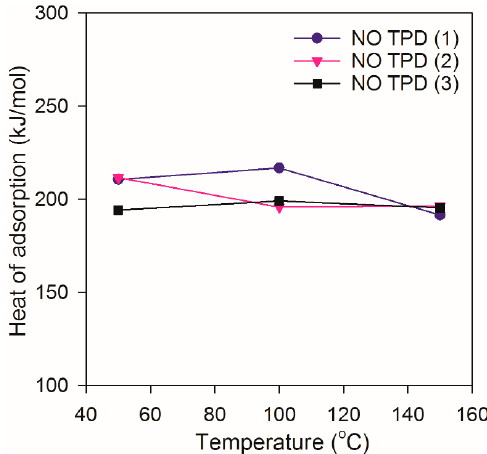
Figure 4. Averaged adsorption heats of NO at adsorption temperatures of 50 °C, 100 °C, and 150 °C over 2% Pt/Al 2 O 3 catalyst. Experimental details are described in Section 3.